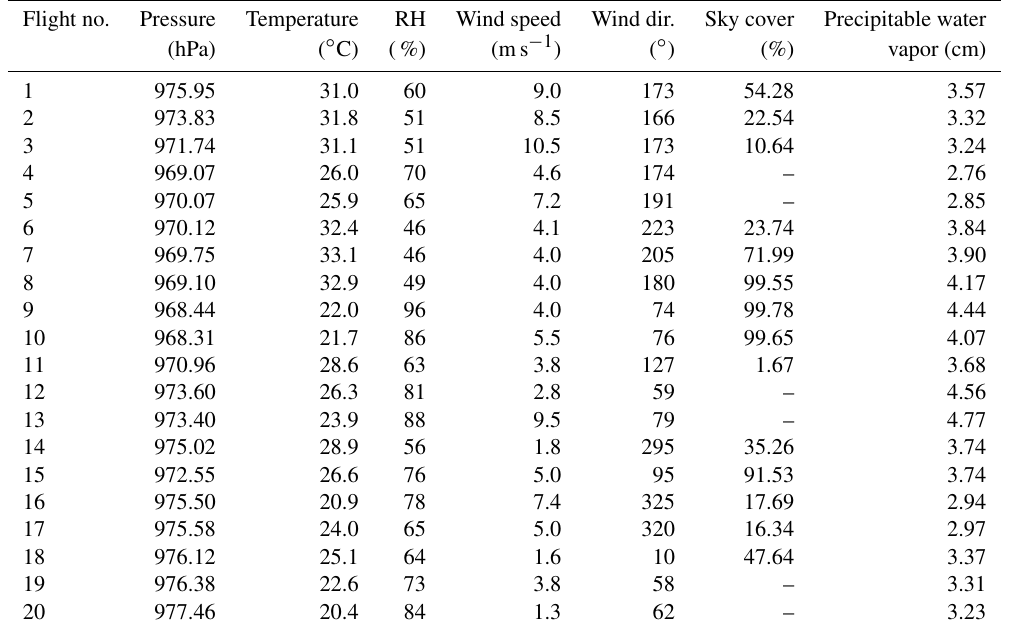
Table 6. Surface observations of meteorological state for each launch. Pressure, temperature, relative humidity, wind speed, and wind di- rection observations are from THWAPS (temperature, humidity, wind, and pressure sensor; www.arm.gov/instruments/thwaps). Sky cover is from the total sky imager, and precipitable water vapor is from the microwave radiometer. Flight no.